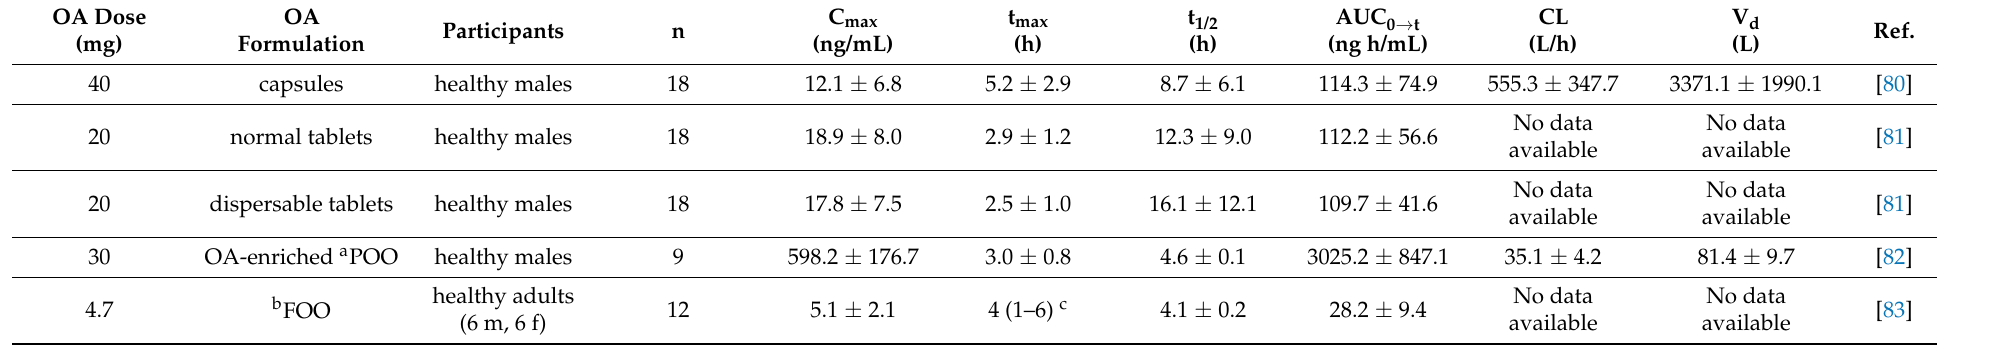
Table 1. Pharmacokinetic parameters of oleanolic acid (OA) in human serum after oral single-dose